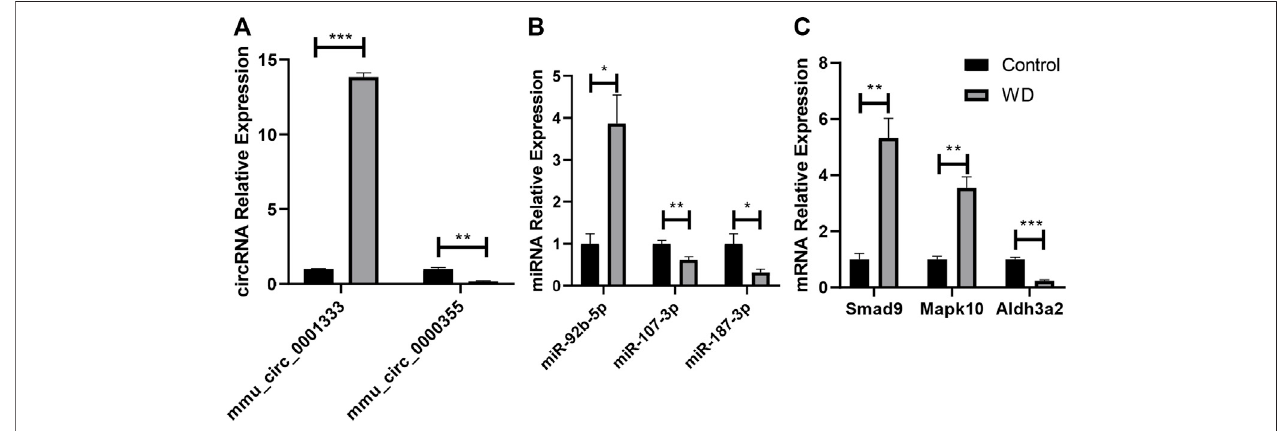
FIGURE 8 | Validation of DE RNAs selected. (A) circRNAs; (B) miRNAs; (C) protein-coding genes. Expression was normalized to U6 for miRNAs and GAPDH for circRNAs and mRNAs as internal controls. Data are presented as the mean ± standard deviation ( n = 3, * p < 0.05, ** p < 0.01, *** p <